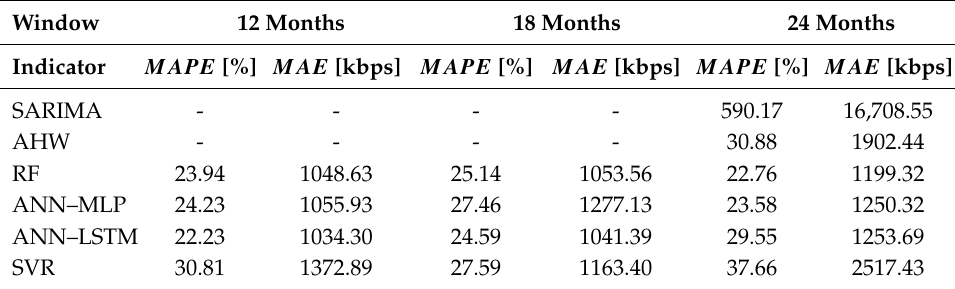
Table 3. Impact of observation window for 6-month